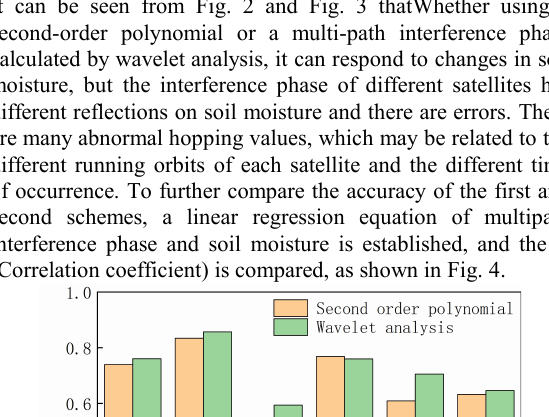
Fig 3. Multipath interference phase of scheme 2